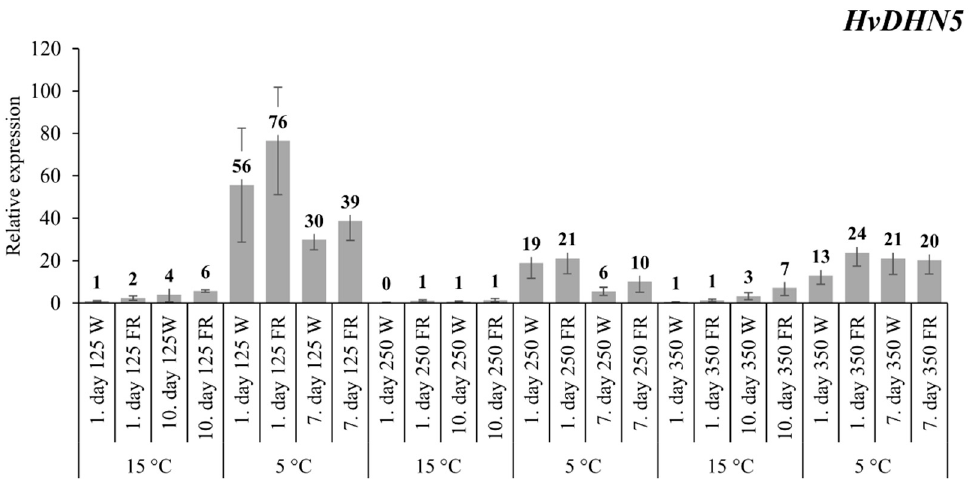
Figure 3. The expression pattern of the HvDHN5 gene with white light and low R:FR illumination. Conditions are the same as in Figure 1.